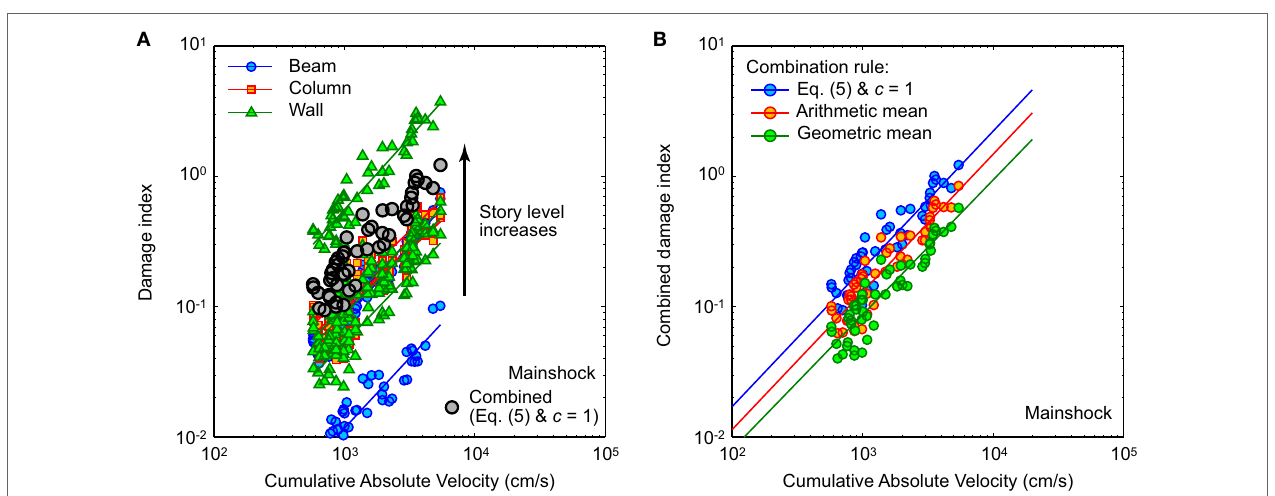
FIGURE 8 | (A) Comparison of local damage indices with the combined damage index in the plastic hinge zone for MS records. (B) Comparison of three combined damage indices in the plastic hinge zone for MS records.